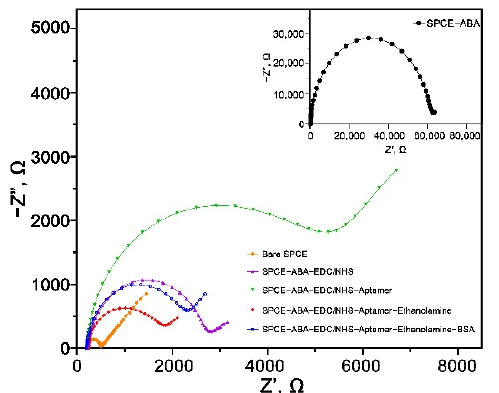
Figure 5. Nyquist plot of the stepwise electrode modification in 5 mM [Fe(CN) 6 ] 3 − /4 − solution containing 0.1 M KCl with the frequency ranging from 100 kHz to 0.01 Hz.